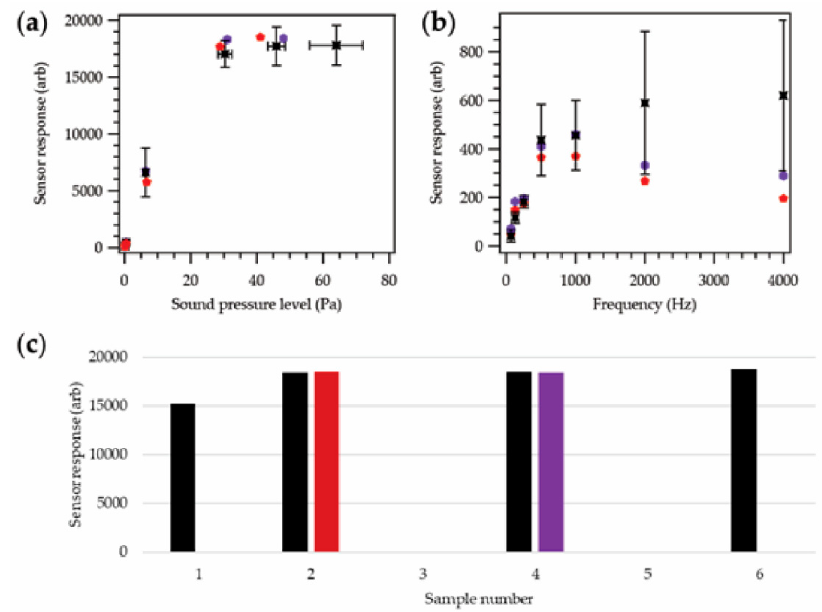
Figure 6. Sensor response for the acoustic sensing yarns where the hardware module was used. Experiments were conducted using the acoustic sensing yarns before (black; ) and after (red and purple; , ) the yarns were inserted within the helmet cover. ( a ) Sensor response as a function of sound pressure level at a fixed frequency of 1000 Hz. Tests were carried out between 0.1 and 8.1 Pa (73.8–112.1 dB), with the sensor operating correctly at all amplitudes across this range. For the acoustic sensing yarn outside of the cover (black), averaged data using four samples is shown. ( b ) Sensor response as a function of frequency at a fixed sound pressure level of 0.43 ± 0.02 Pa. For the acoustic sensing yarn outside of the cover (black), averaged data using four samples is shown. An 8000 Hz signal was also tested; the variation in results at this frequency was very high, and it has been negated from the graph for clarity. Variation in the result when the hardware module was used was also seen to be significant at high frequencies (2000 Hz and 4000 Hz). ( c ) Sensor response for the four acoustic sensing yarns at a fixed input sound of 45.5 ± 3.1 Pa with a 1000 Hz frequency. The sample numbers are consistent with Figure 3.